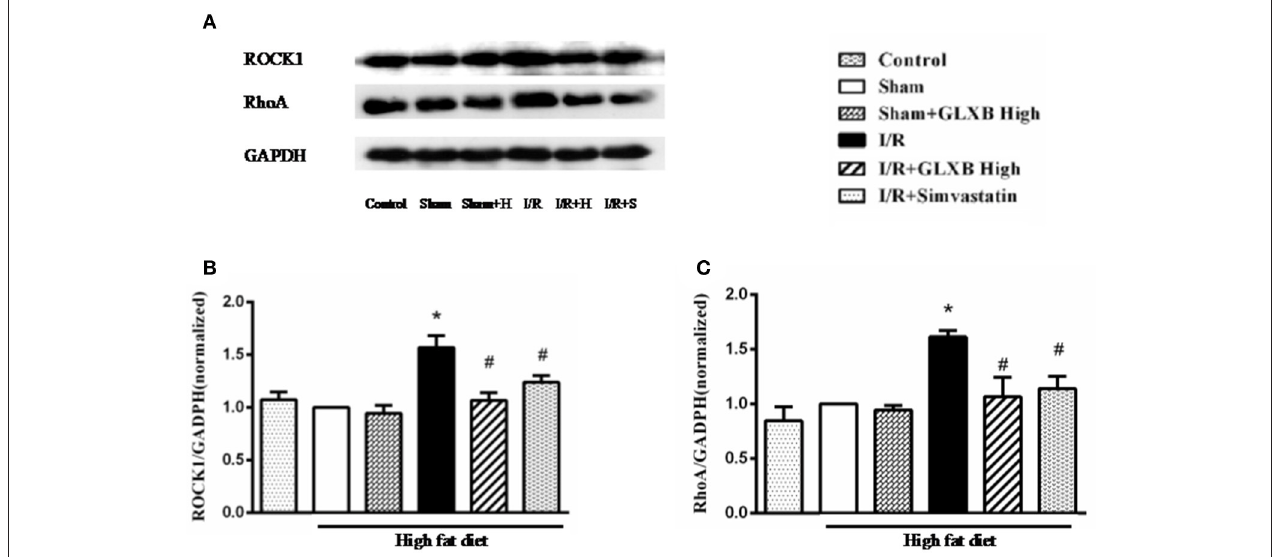
FIGURE 7 | Effect of GLXB on the expression of RhoA/ROCK signaling pathway in the myocardial tissue of rats subjected to I/R. (A) Representative Western blotting bands of RhoA and ROCK1 in various groups. (B) The semi-quantitative analysis of RhoA in various groups. (C) The semi-quantitative analysis of ROCK1 in various groups. Data are mean ± SEM, n = 6. * P < 0.05 vs. Sham group, # P < 0.05 vs. I/R group.